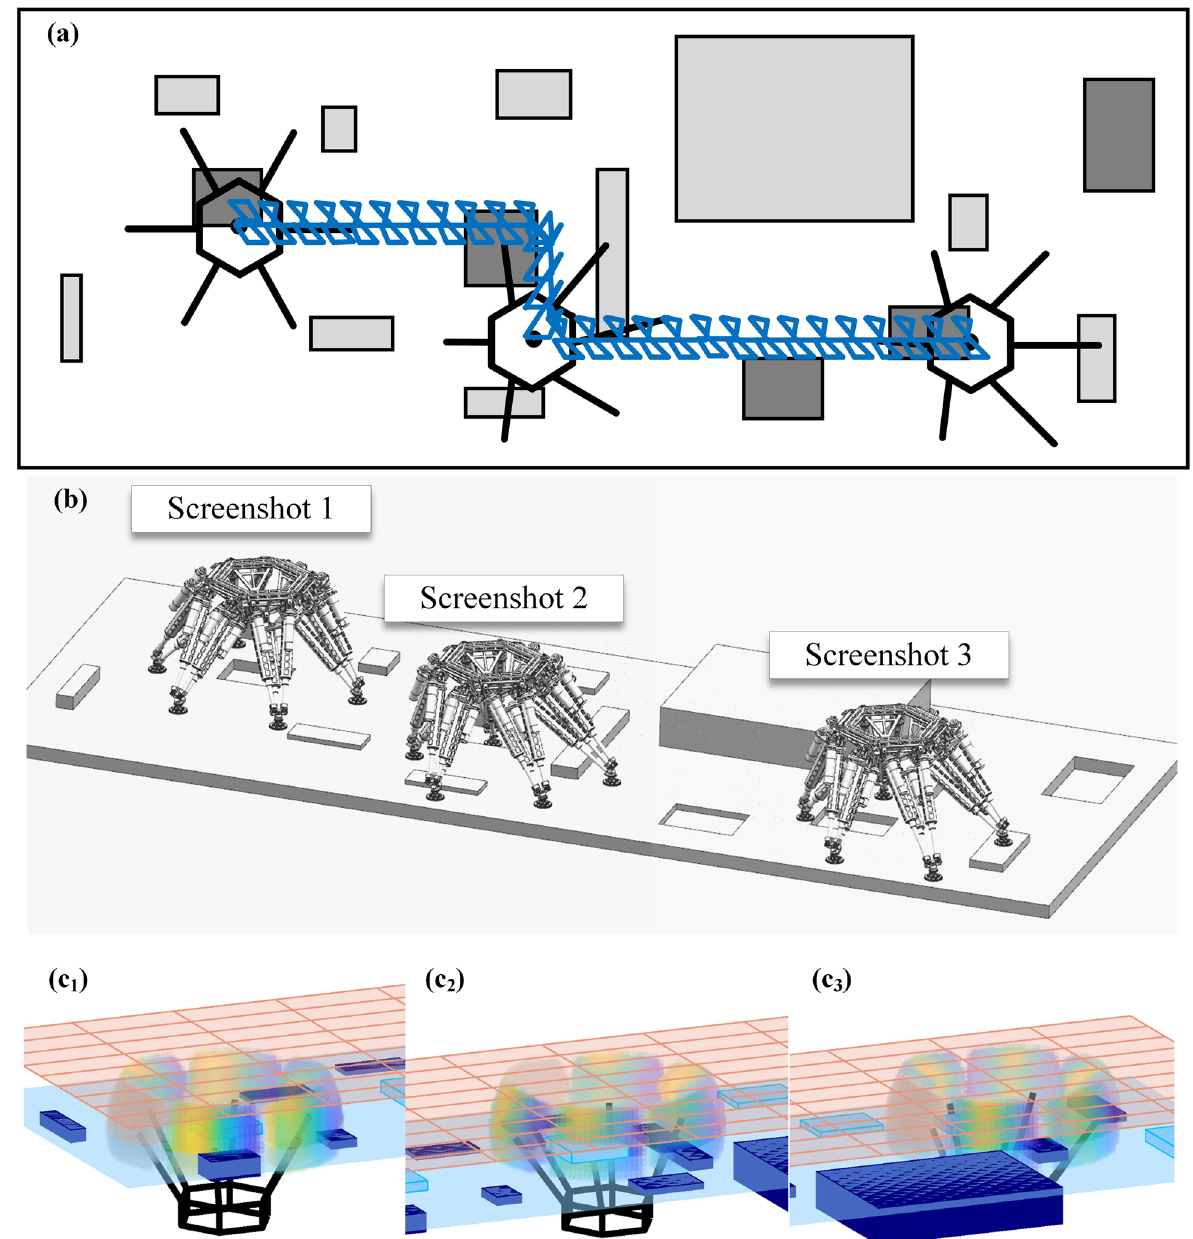
Figure 11 Octopus robot walking on rough terrain with free gait: a Octopus robot free gait simulation (top view), b UG motion simulation capturing four screenshots 1 ‒ 3, c 1 ‒ c 3 motion simulation with motion stability index using Inverted Modelling corresponding to the three moments of screenshot 1 ‒ 3